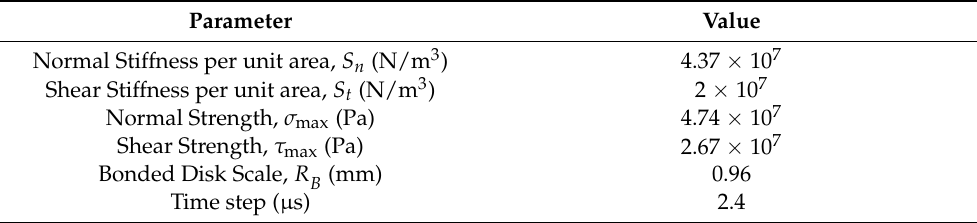
Table 1. Key Parameter in DEM model.